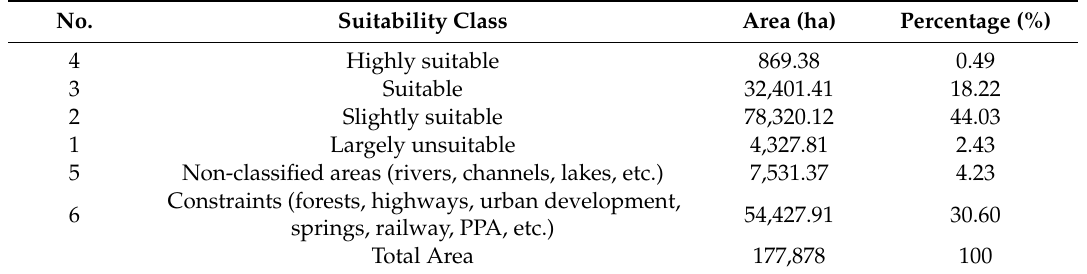
Table 7. Area and percentage of fish farming suitability classes in the study area.